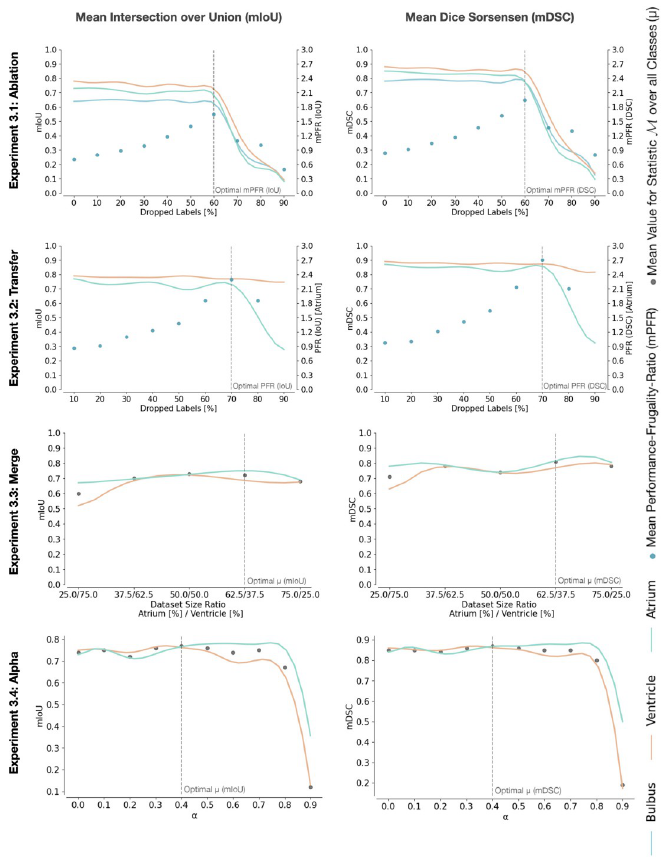
Fig 3. Experiments. Visualization of the conducted experiments. Each row is an experiment, each column the applied statistic. The scatter points in each plot indicate the value for the respective method to measure performance, either the mean Performance Frugality Ratio PFR over the observed classes or the mean value ( μ ) over the respective statistic. The optimal performance is highlighted with a vertical dotted line. The plotted values are presented as a moving average with kernel size two. The left axis corresponds to the respective statistic, the right axis, if it is present, to the respective PFR. For details see S1 File.